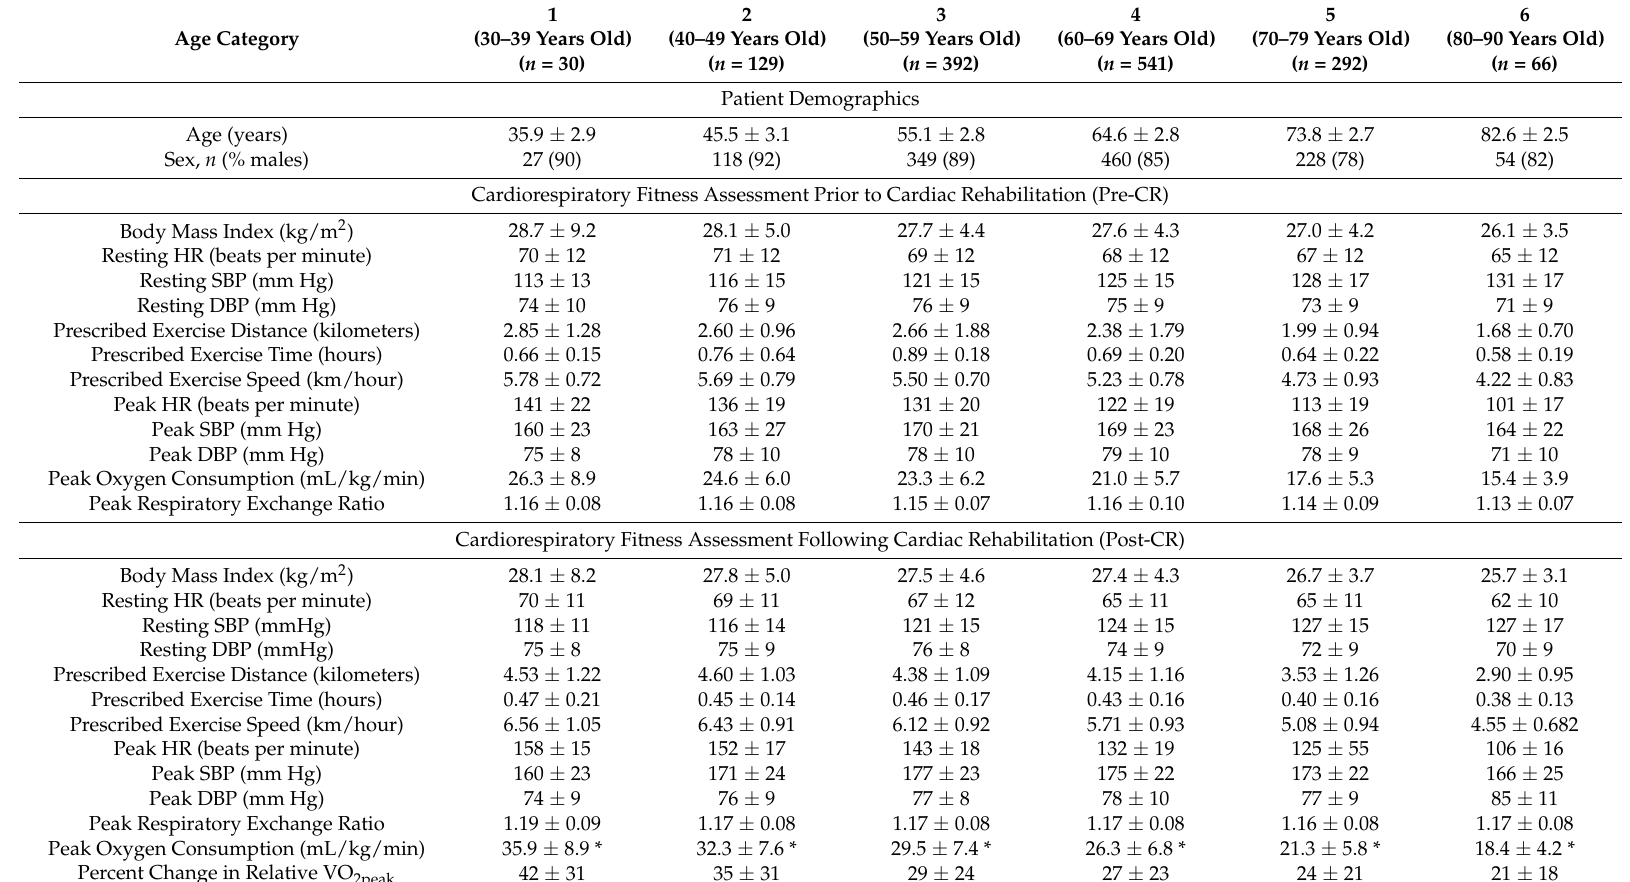
Table 2. Demographics and cardiorespiratory fitness at baseline and following cardiac rehabilitation